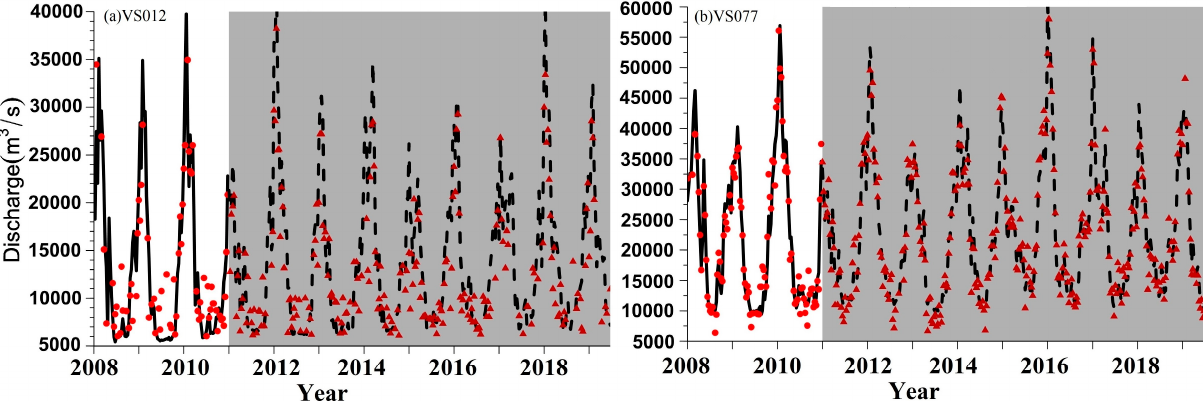
Figure 4. Water level retrievals (m a . s.l.) of satellite radar altimetry at ( a ) VS012 and ( b ) VS 077 between 2008 and 2019.